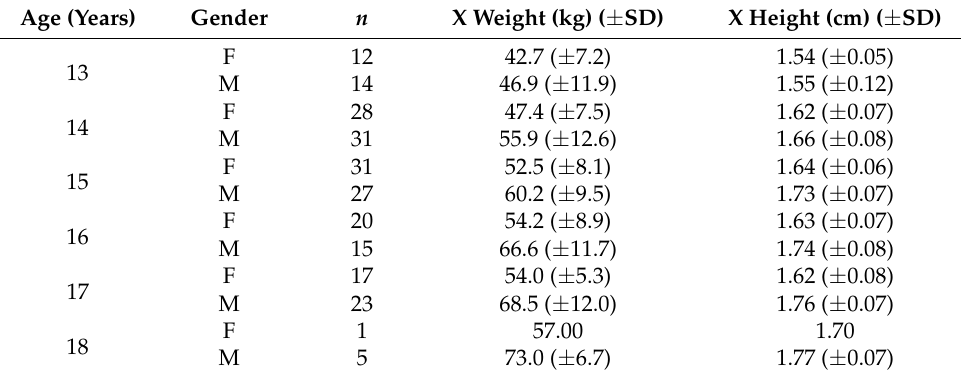
Table 1. Descriptive data of the